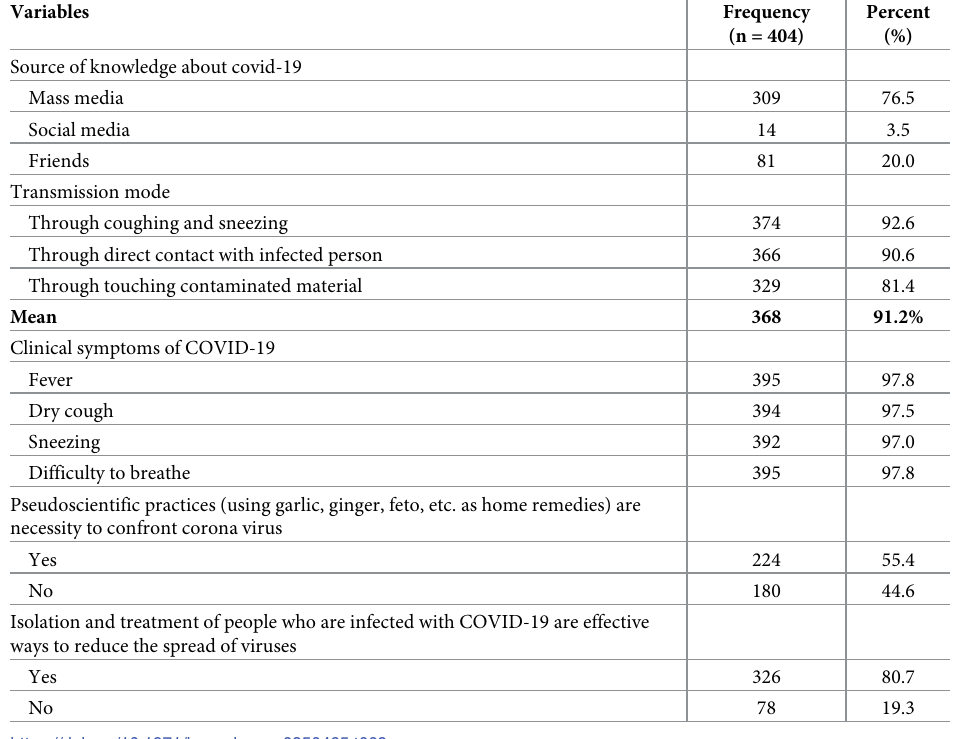
Table 2. Knowledge of the respondents towards COVID-19 (n = 404).